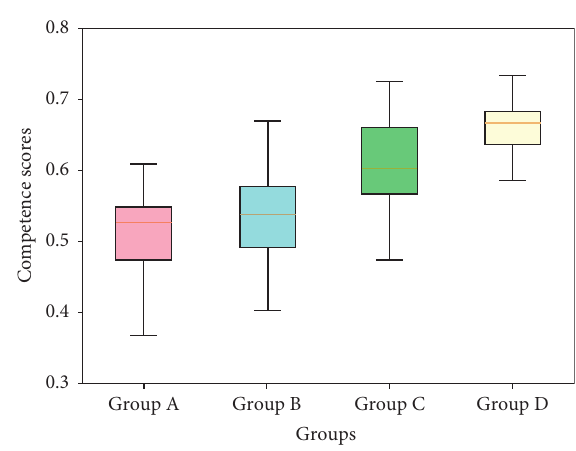
Figure 8: Competence scores of different